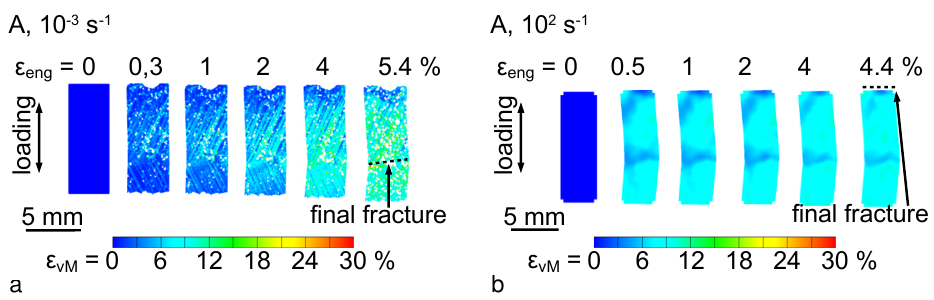
Fig. 4: Results of the digital image correlation for material A at loading rates of 10 − 3 s − 1 (a) and 10 2 s − 1 (b). ε eng – engineering strain, ε vM – von Mises equivalent strain.